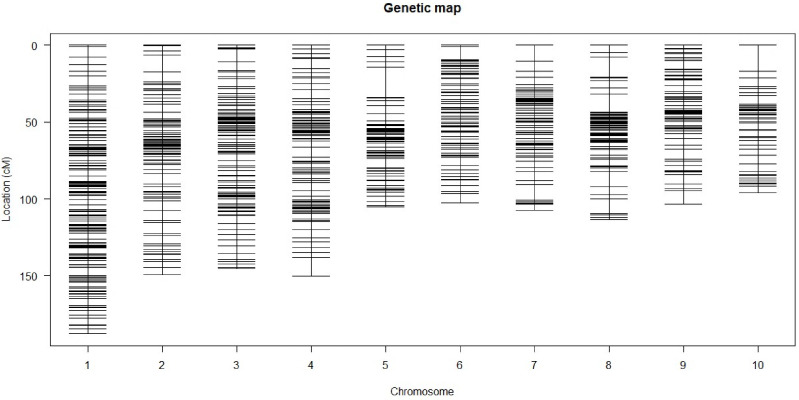
Genetic map.Plot representing the estimated genetic map and the marker distribution across the ten chromosomes of maize for the CML312 × W22 castor-2 F2 population.